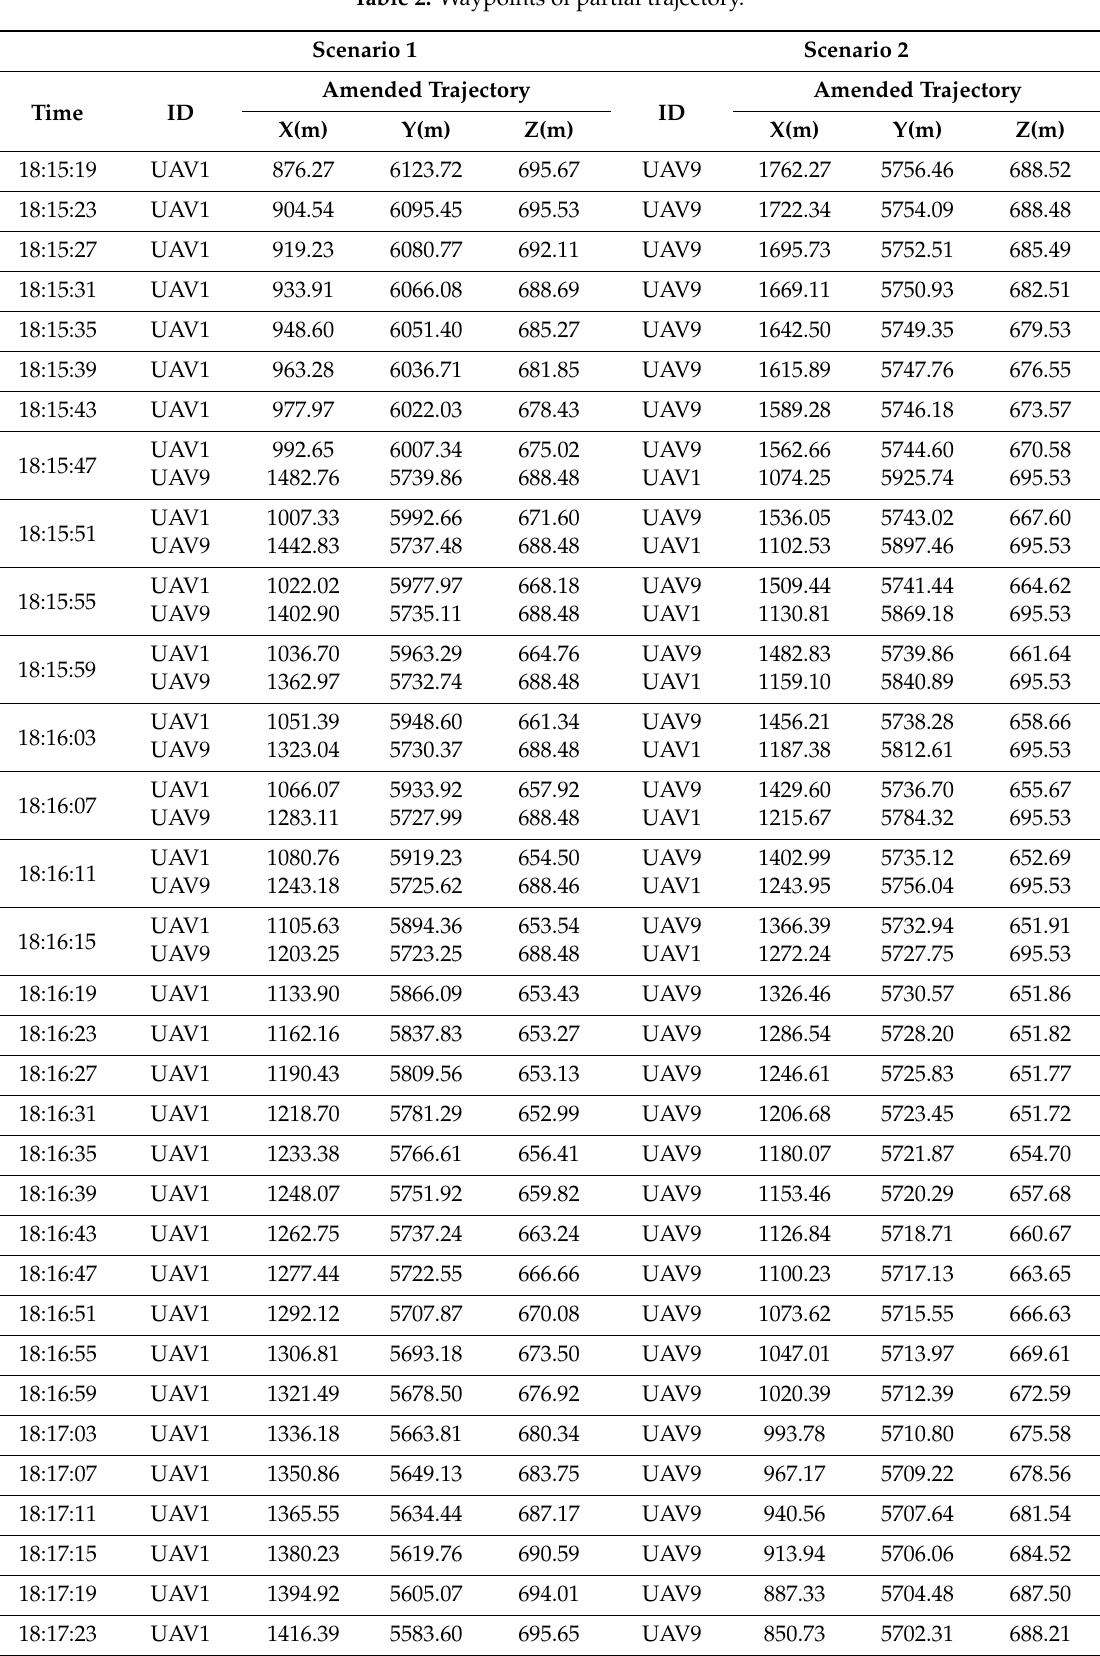
Table 2. Waypoints of partial